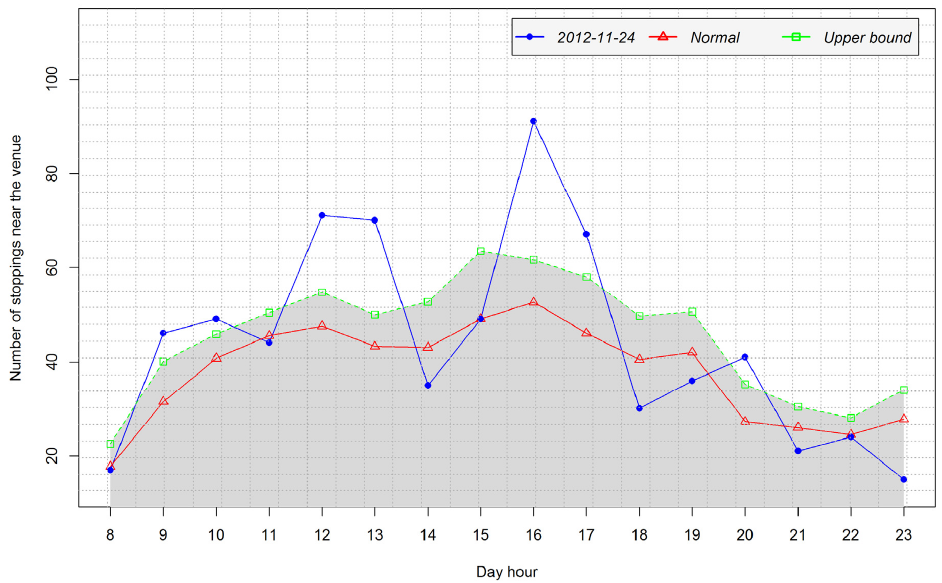
Figure 8. Temporal variation of the number of stoppings near the venue (P) , its normal value ( Q ), and its upper bound ( UP ) on a day with an event.